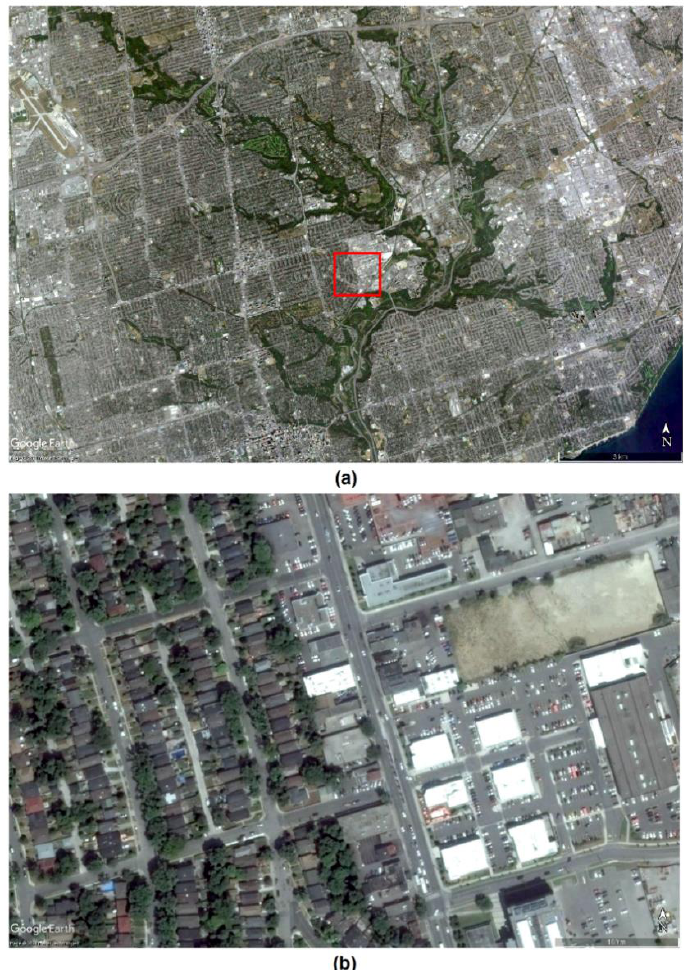
Figure 4. Google Earth images of a portion of the study area. The images show ( a ) a segment of the study area with vegetation cover and ( b ) a magnified image of the segment.